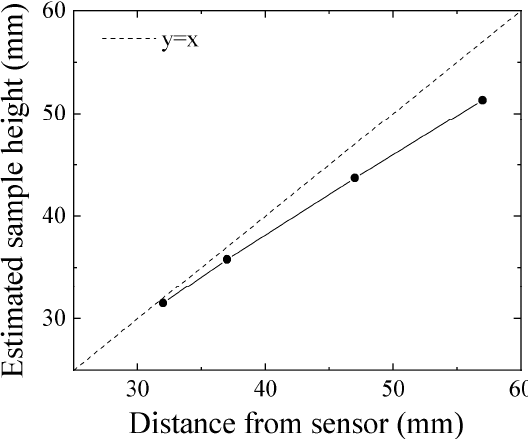
Figure 19. Experimental results of height estimation.